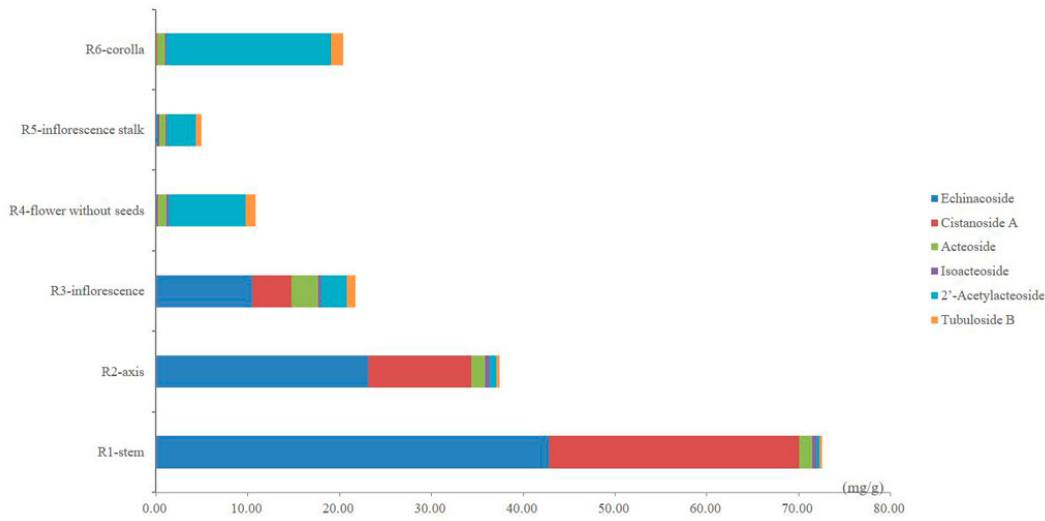
Figure 4. The bar graph of the average contents of six PhGs in samples from six different parts of cultivated C. deserticola .